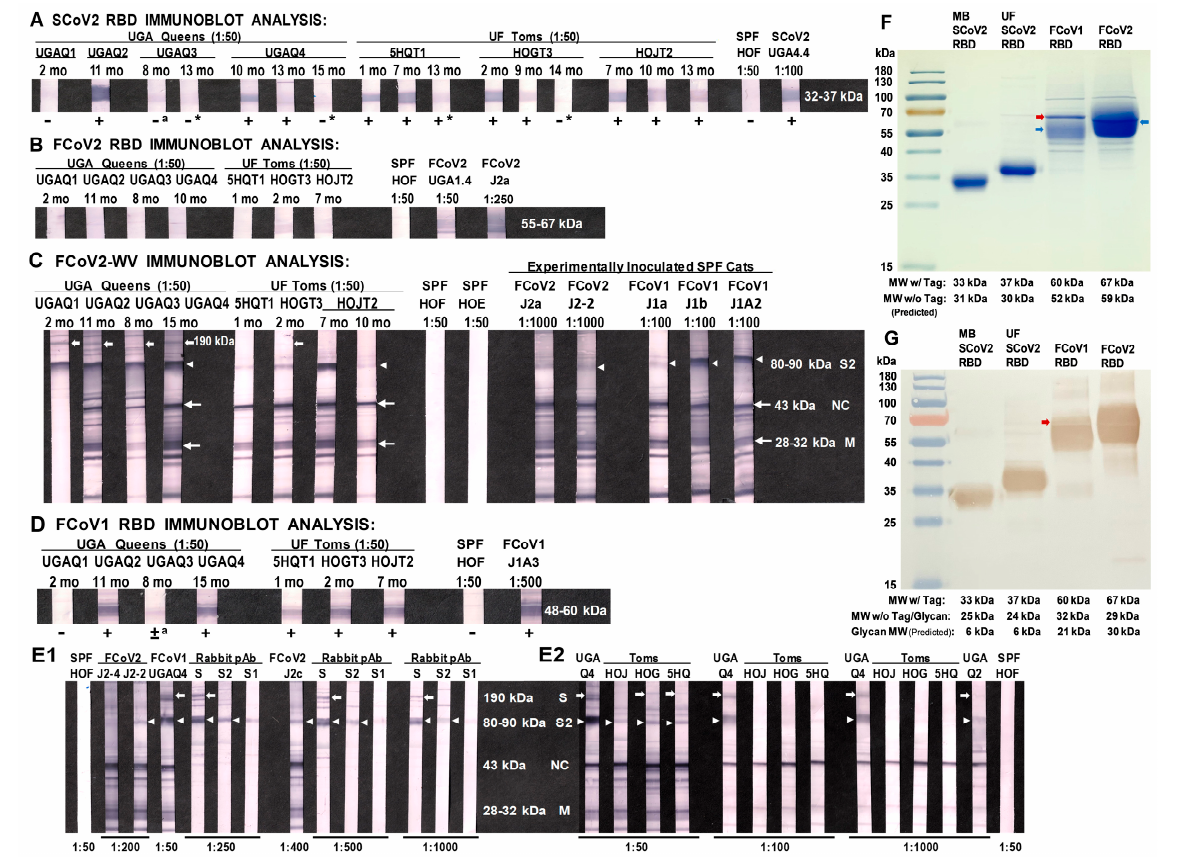
Figure 3. Immunoblot analyses of the sera from FCoV + queens and SCoV2 RBD-positive toms followed by MW analyses of the RBDs. Immunoblots were developed for the SCoV2 UF-RBD ( A ), the proposed FCoV2 RBD ( B ), the cross-reactive FCoV2-WV ( C ), and the proposed FCoV1 RBD ( D ). The results for SCoV2 UF-RBD ( A ) and FCoV1 RBD ( D ) are shown below the immunoblot strip, with the summary result of either a positive (+) or negative ( − ). Those with an asterisk (*) shown were supported by the result in Figure S10, and those with a subscript “a” shown were supported by the result performed at 1:25 dilution (data not shown). Similar to Figure 1D,E, the time of serum collection from four FCoV + queens is shown as time post arrival to UF, and those from the toms are shown as time post-first exposure to an FCoV + queen. The MW size range for the RBD bands SCoV2, FCoV2, and FCoV1 are shown next to the control bands. The bands for FCoV2 structural proteins in FCoV2-WV immunoblot ( C ) are 43 kDa for NC (long arrow), 28–32 kDa for M (long arrow), and 80–90 kDa for spike-2 glycoprotein (S2) (arrow head). The 190 kDa band (short arrow) in the FCoV2- WV immunoblot strips is the S glycoprotein, confirmed by a cross-reactivity analysis using rabbit polyclonal antibodies (pAb) to SCoV2 S2 (Sigma ABF1063) and SCoV2 S (Sigma ABF1066), which cross-reacted with FCoV2 S2 and S, respectively ( E1 ). The rabbit pAb to SCoV2 S1 (Sigma ABF1065) did not cross-react with FCoV2 S1 on immunoblot. Consequently, it served as rabbit control pAb to detect non-specific trapping of the rabbit pAb to the FCoV2 S2 band, which had the highest antigen load on the immunoblot. The same analysis was performed at three serum dilutions for UGAQ4 and three toms (HOJT2, HOGT3, and 5HQT1), with UGAQ2 only at 1:1000 using the immunoblot of the same batch ( E2 ). The sera collected on the day of euthanasia were used for UGAQ4 and the three toms ( E2 ). All immunoblot photographs were adjusted for consistency to 10% brightness and 5% contrast. The actual MW of the RBDs used in the immunoblot analyses was determined by Coomassie blue staining of RBD gel ( F ) and Penta-His MAb treated RBD immunoblot ( G ). The SCoV2 UF-RBD, FCoV1 RBD, and FCoV2 RBD used the same plasmid with cleavage site peptide and two tags (70